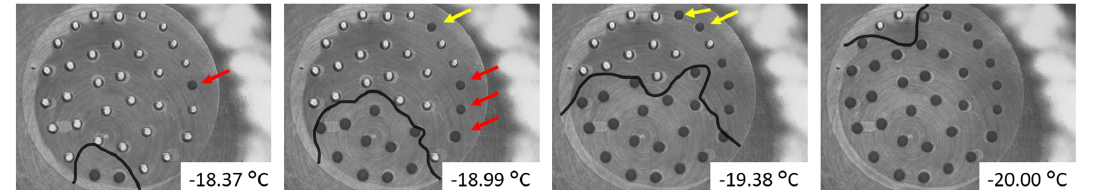
Figure 2. Progression of frost halos in one pure water droplet freezing experiment without an oil matrix. Dark droplets are frozen. The black line highlights the frost growth (which is visible in the image but difficult to see) spreading from the bottom left toward the top of the image. Aside from the indicated frost growth, we can also see that other droplets induce freezing in neighboring droplets, such as the droplet on the far right in image 1 (red arrow) and the top right droplet in image 2 (yellow arrow). Subsequently induced droplets are indicated by similarly colored